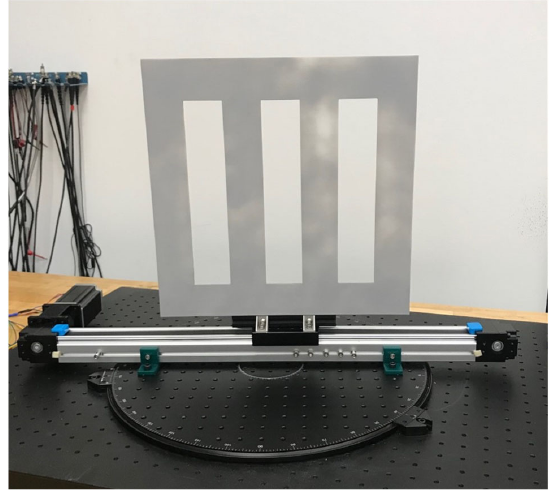
Figure 8. Linear motion device with a target having vertical openings mounted to a rotating optical breadboard.